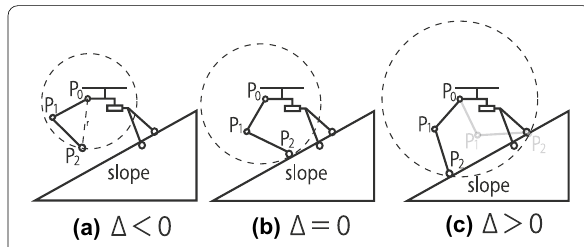
Fig. 7 The positional relationship between p 2 and the